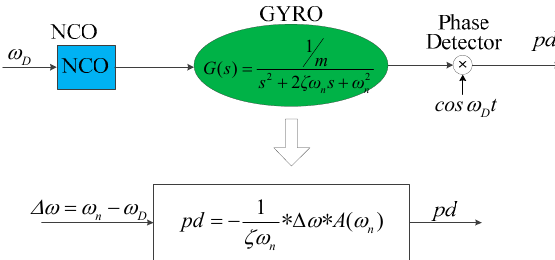
Figure 14. The models < oscillator–gyroscope–phase detector > in series are approximated as a gain term.